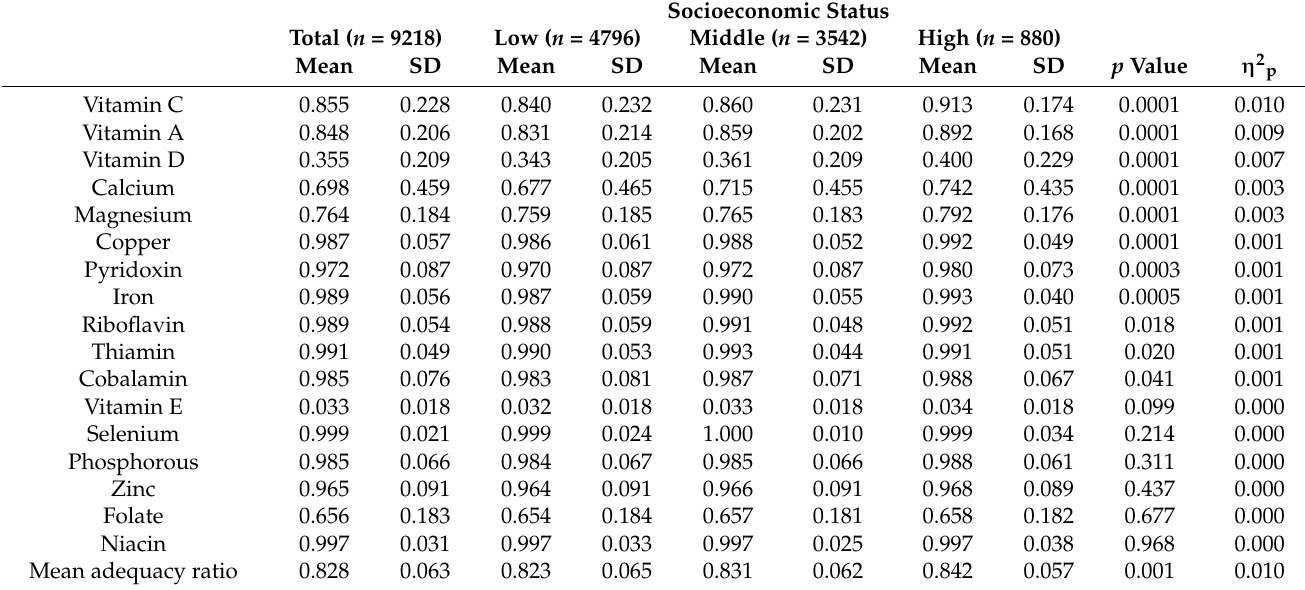
Table 3. Micronutrient adequacy ratio by socioeconomic status—the Latin American Health and Nutrition Study